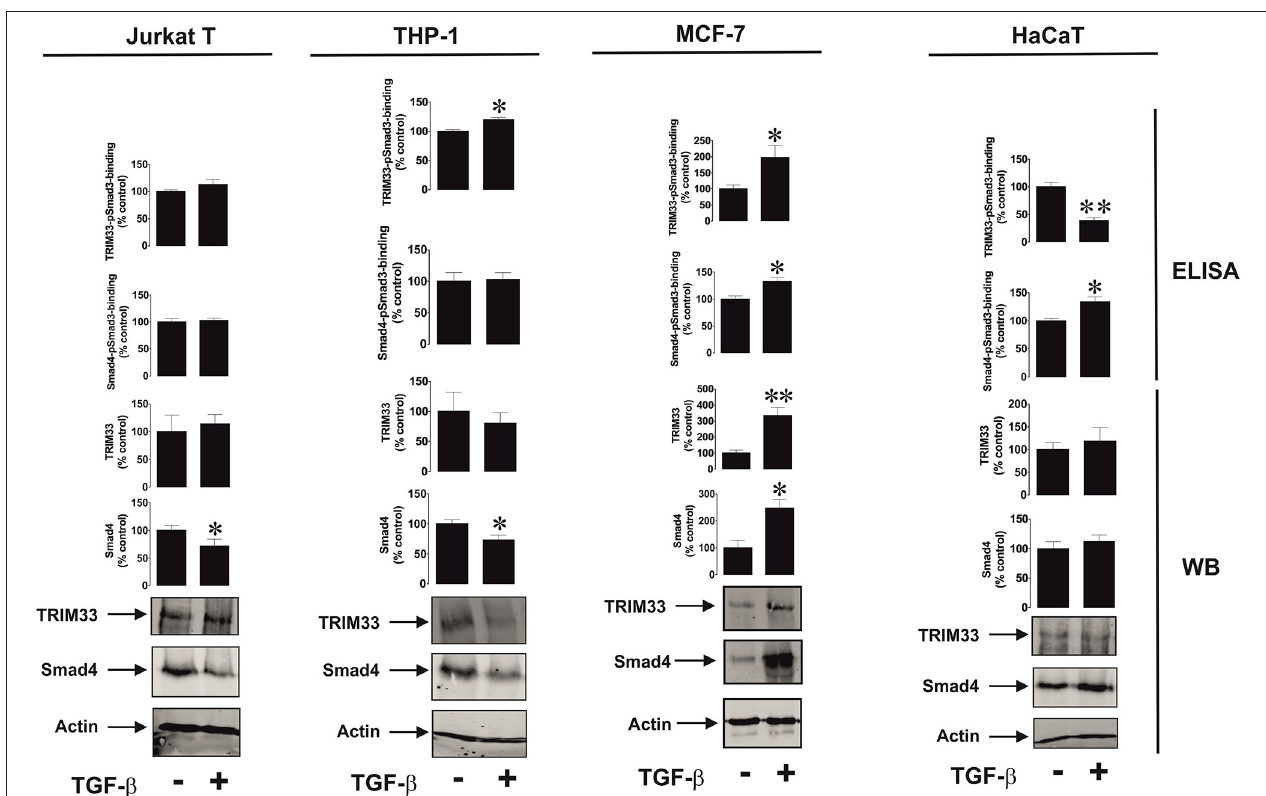
FIGURE 3 | Effects of TGF- β on Smad4 and TRIM-33 levels and phsopho-Smad3-Smad4 or phsopho-Smad3-TRIM33 interactions in a variety of rapidly proliferating human cells. Jurkat T, THP-1, MCF-7 and HaCaT cells were exposed to 2ng/ml TGF- β for 24h followed by Western blot detection of Smad4/TRIM-33 levels as well as ELISA-based analysis of phospho-Smad3-Smad4 or phospho-Smad3-TRIM33 interactions. Images are from 1 experiment representative of 4 which gave similar results. Quantitative data represent mean values ± SEM of 4 independent experiments. * p < 0.05 and ** p < 0.01 vs.